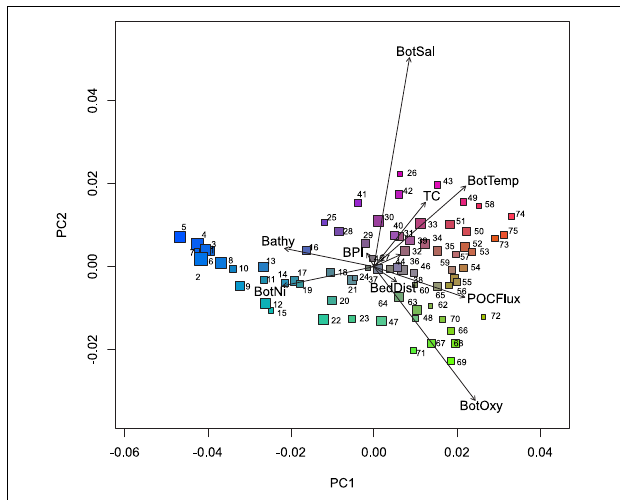
FIGURE 4 | Principal component analysis of the seafloor community classification groups (75 groups) for the New Zealand marine environment. Vectors indicate correlations with the nine most important environmental predictors and symbol size indicates the relative spatial area represented by the group. Colours are based on the first three axes of the PCA analysis applied to the group means for each of the transformed predictor variables, so that similarities/differences in colour correspond broadly to similarities/differences in predicted compositional turnover. Environmental predictors include: bathymetry ( Bathy ), benthic sediment disturbance ( BedDist ), bottom nitrate ( BotNi ), dissolved oxygen at depth ( BotOxy ), salinity at depth ( BotSal ), temperature at depth ( BotTemp ), broadscale Bathymetric Position Index ( BPI ), downward vertical flux of particulate organic matter at the seabed ( POCFlux ) and tidal current speed ( TC